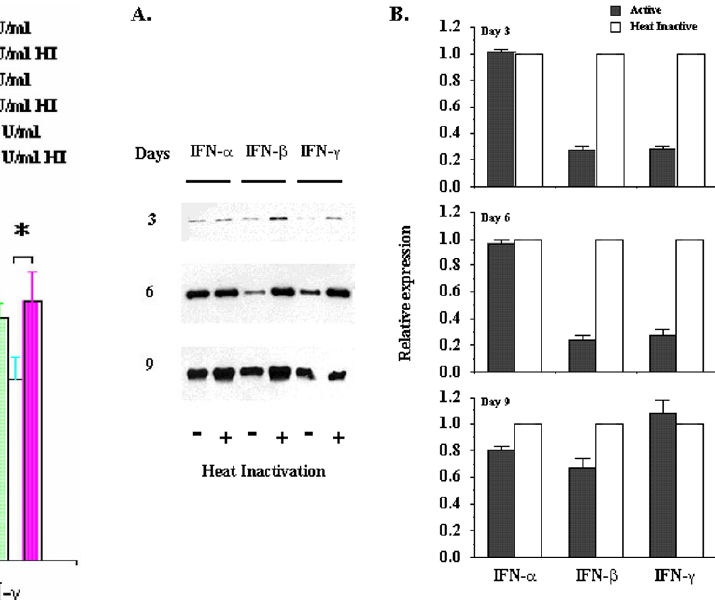
Figure 4 Dose dependent effect of IFNs on rat HSC proliferation. Sub-cultured HSCs were incubated with three concentra- tions of IFNs (100, 500 and 1000 U/ml) for 6 days. WST-1 cell proliferation reagents assayed cell proliferation. The data represent mean ± SEM. HI represents heat-inactivation. * presents p < 0.05 and ** indicated p < 0.01